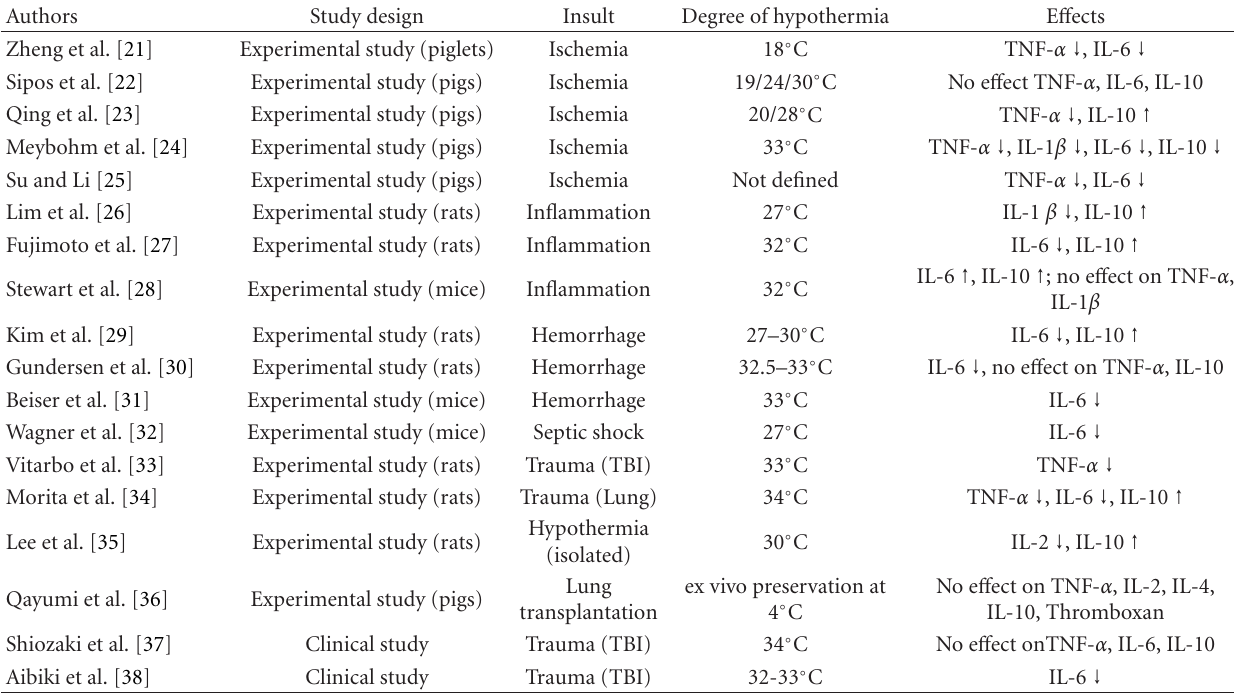
Table 3: E ff ects of hypothermia on inflammatory